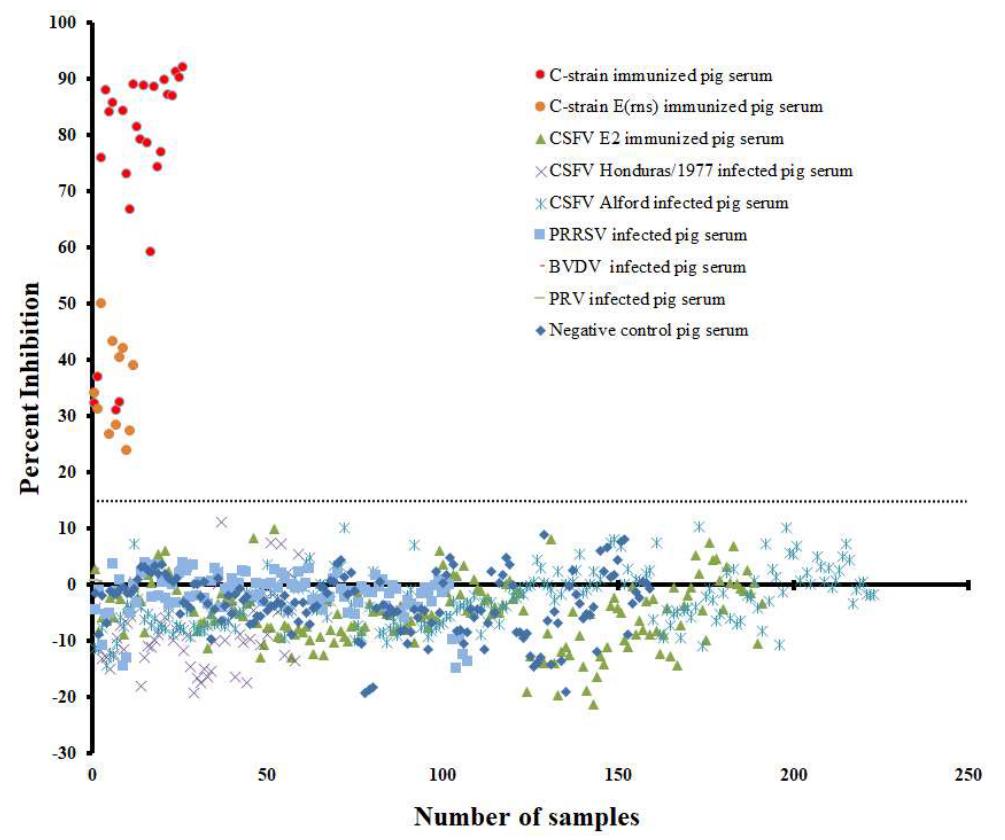
Figure 4. Validating the diagnostic specificity of the mAb1504-based cELISA. The dotted line represents cut-off value of 16.39% inhibition when using the mean PI of negative sera plus three SD as the threshold.